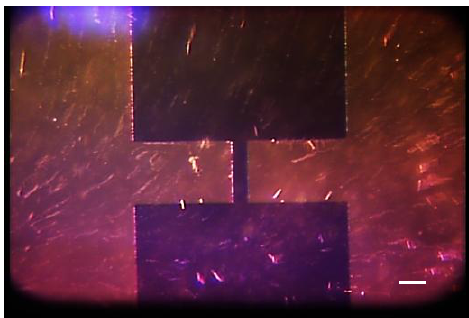
Figure 6. Behavior of 15 µm-long nanowires under electroosmosis. Applied voltage is 4 V at 100 Hz. The scale bar is 100 pp